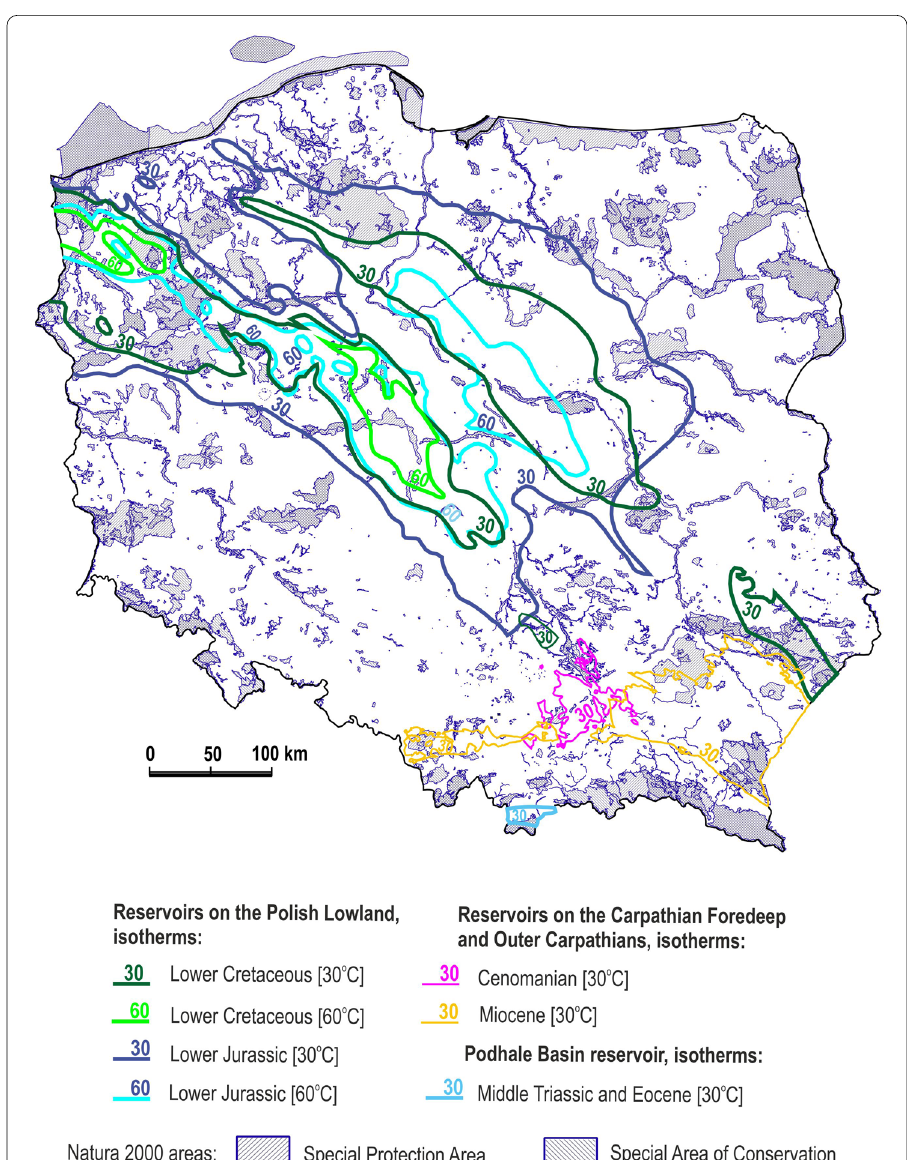
Fig. 6 Geothermal water reservoirs proposed for agricultural uses in Poland against the map of the objects of the European Network Natura 2000 areas. Scientific description based on Barbacki et al. (2016) ; ranges of reservoirs with temperatures > 30 ◦ C and > 60 ◦ C according to maps by Górecki et al. (2006, 2011, 2012, 2013); underlay the Map of the Nature 2000 areas (GDEP 2021; HOGC